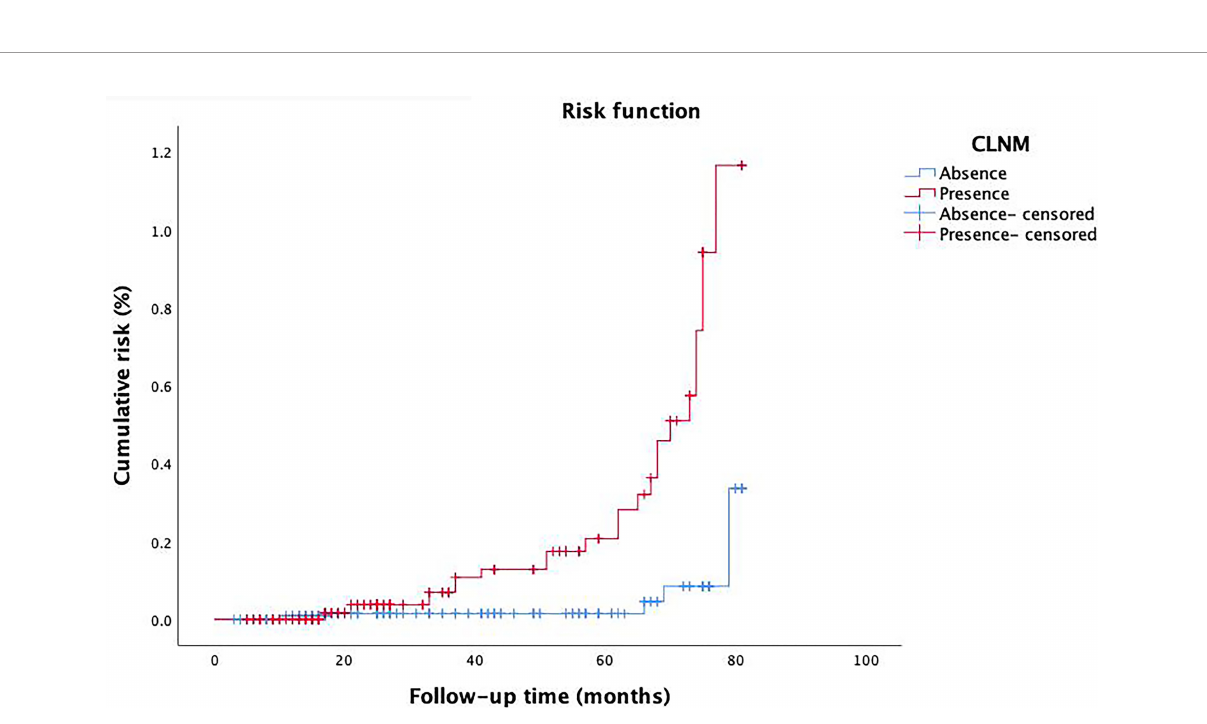
FIGURE 5 | The cumulative risk in patients with CLNM and patients without